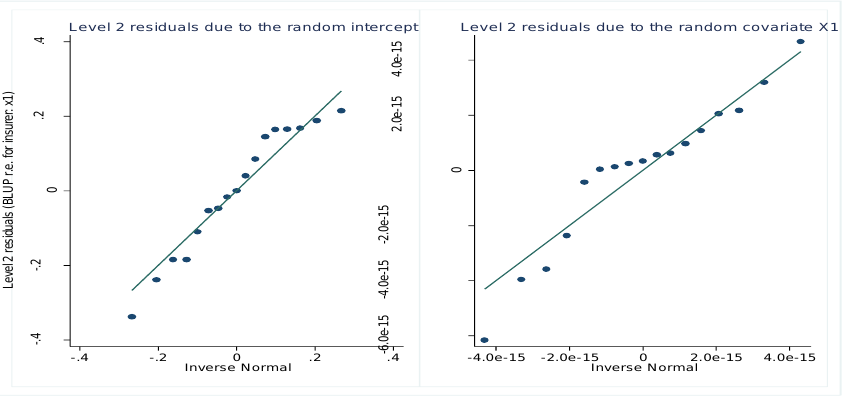
Figure 4: Q-Q plots line-up by insurer for level-1 residuals; Assurance Customer satisfaction model Level 2 residuals based on the q-q plots showed possible deviations for this model fitted to assess the influence of service assurance on customer satisfaction (Figure 5). In this model, multiple level-2 residuals were considered as random covariates and as Random intercepts in the random effect. The level-2 residuals were BLUPs from the random intercepts (level-2 group constant terms) and the BLUPs from the random covariate. The results show elements of deviation from normality by both however the deviations from the line are more notable in the EB BLUPs of the random covariate assurance than on the random intercept BLUPs.